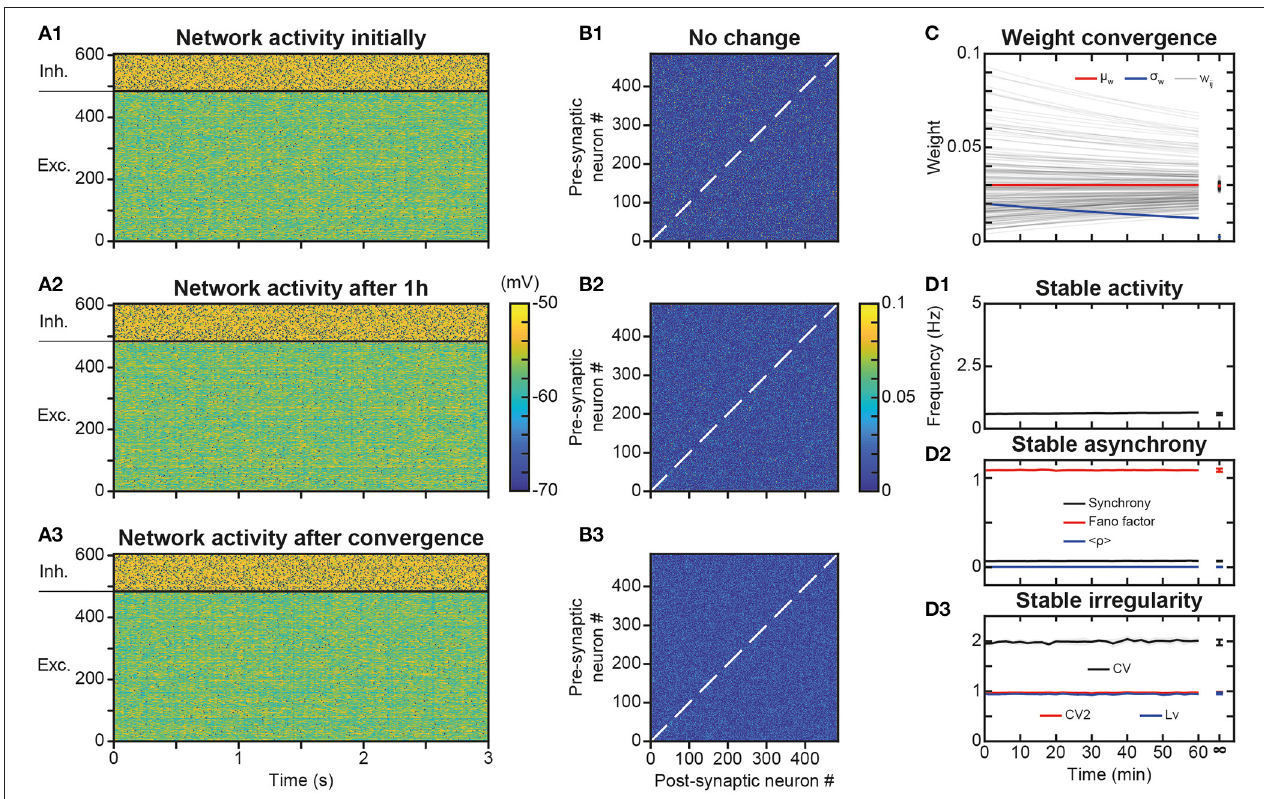
FIGURE 2 | Stability of spontaneous irregular asynchronous (AI) network dynamics under synaptic plasticity. (A1–A3) Membrane potential of network neurons during 3s of spontaneous AI regime in the absence of plasticity (A1) , after 1h of plasticity (A2) and after full convergence of synaptic weights due to plasticity (A3) . The same initial random connectivity matrix is used for simulations in (A1–A3) . Spikes indicated by black dots. Full convergence of the synaptic matrix was obtained by simulating the networks with very fast kinetic constants. (B1–B3) Synaptic weights between excitatory neurons of the network at the end of each of simulations presented in A1–A3 . (C) Convergence of synaptic weights toward the mean weight of their post-synaptic neuron as a function of time, due to synaptic scaling normalization (black curves, see Results). Time evolution of the mean (red curve) and standard deviation (blue curve) of synaptic weights. For sake of clarity, only a random selection of synapses is shown. The mean is constant and the standard deviation decreases with time, due to scaling. (D) . Average excitatory neural spiking frequency (D1) and irregularity (D3) and excitatory population synchrony (D2) quantifiers, as a function of time, for five different simulations of the network with different realizations of the initial random synaptic matrix. Dots on the right indicate values obtained from network simulations after full convergence of synaptic weights. Shaded areas represent 95% confidence intervals of the